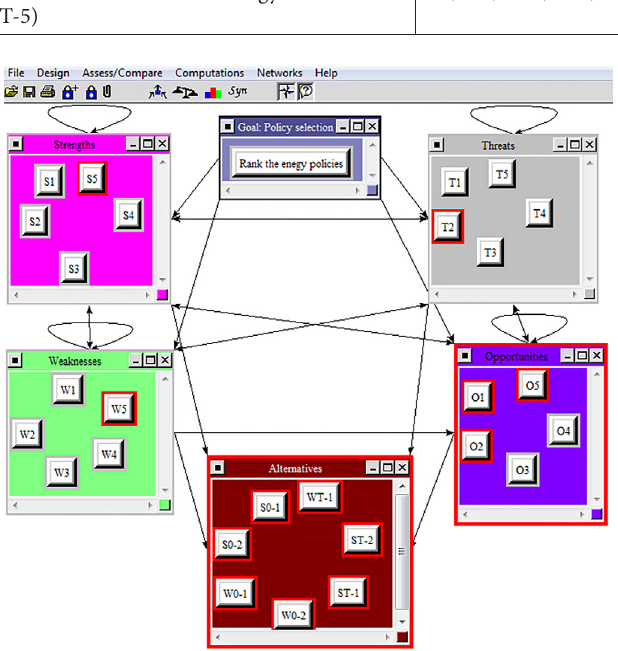
Fig. 5. The network structure of the